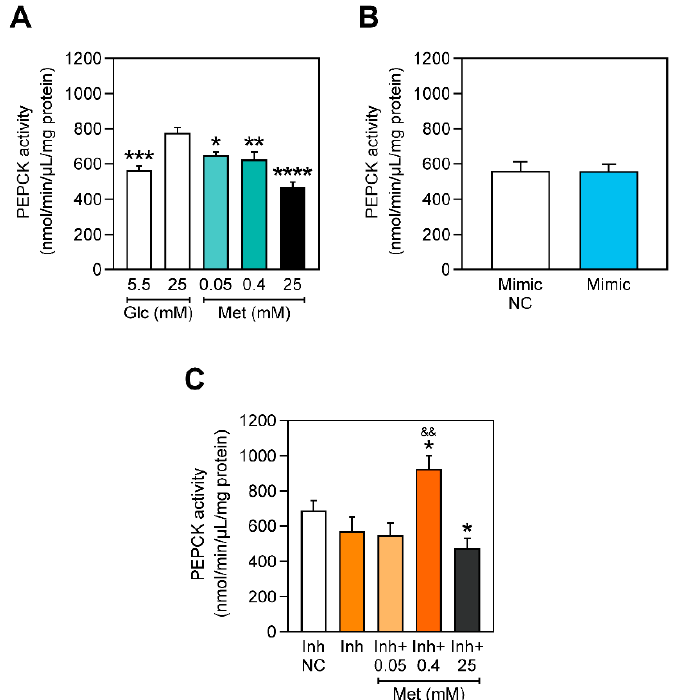
Figure 3. Metformin decreases PEPCK activity but not when miR-378a-3p is inhibited. PEPCK activity ( A ) in cells exposed to 0.05, 0.40 and 25 mM of metformin, ( B ) in cells overexpressing miR- 378a-3p, and ( C ) in cells incubated with miR-378a-3p inhibitors and with 0.05, 0.40 and 25 mM of metformin. All data is given as mean ± S.E.M. ( n = 3). * p = 0.0164 versus Glc 25 mM, ** p = 0.0052 versus Glc 25 mM, *** p = 0.0004 versus Glc 25 mM, **** p < 0.0001 versus Glc 25 mM, * p < 0.04 versus Inh NC, && p = 0.0038 versus Inh.